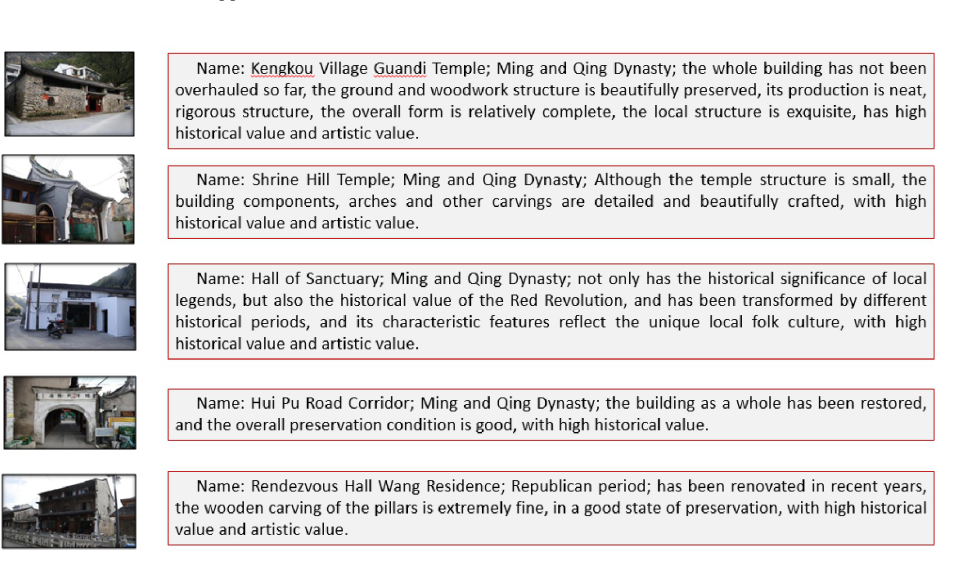
Fig. 5 List of the first category of historic